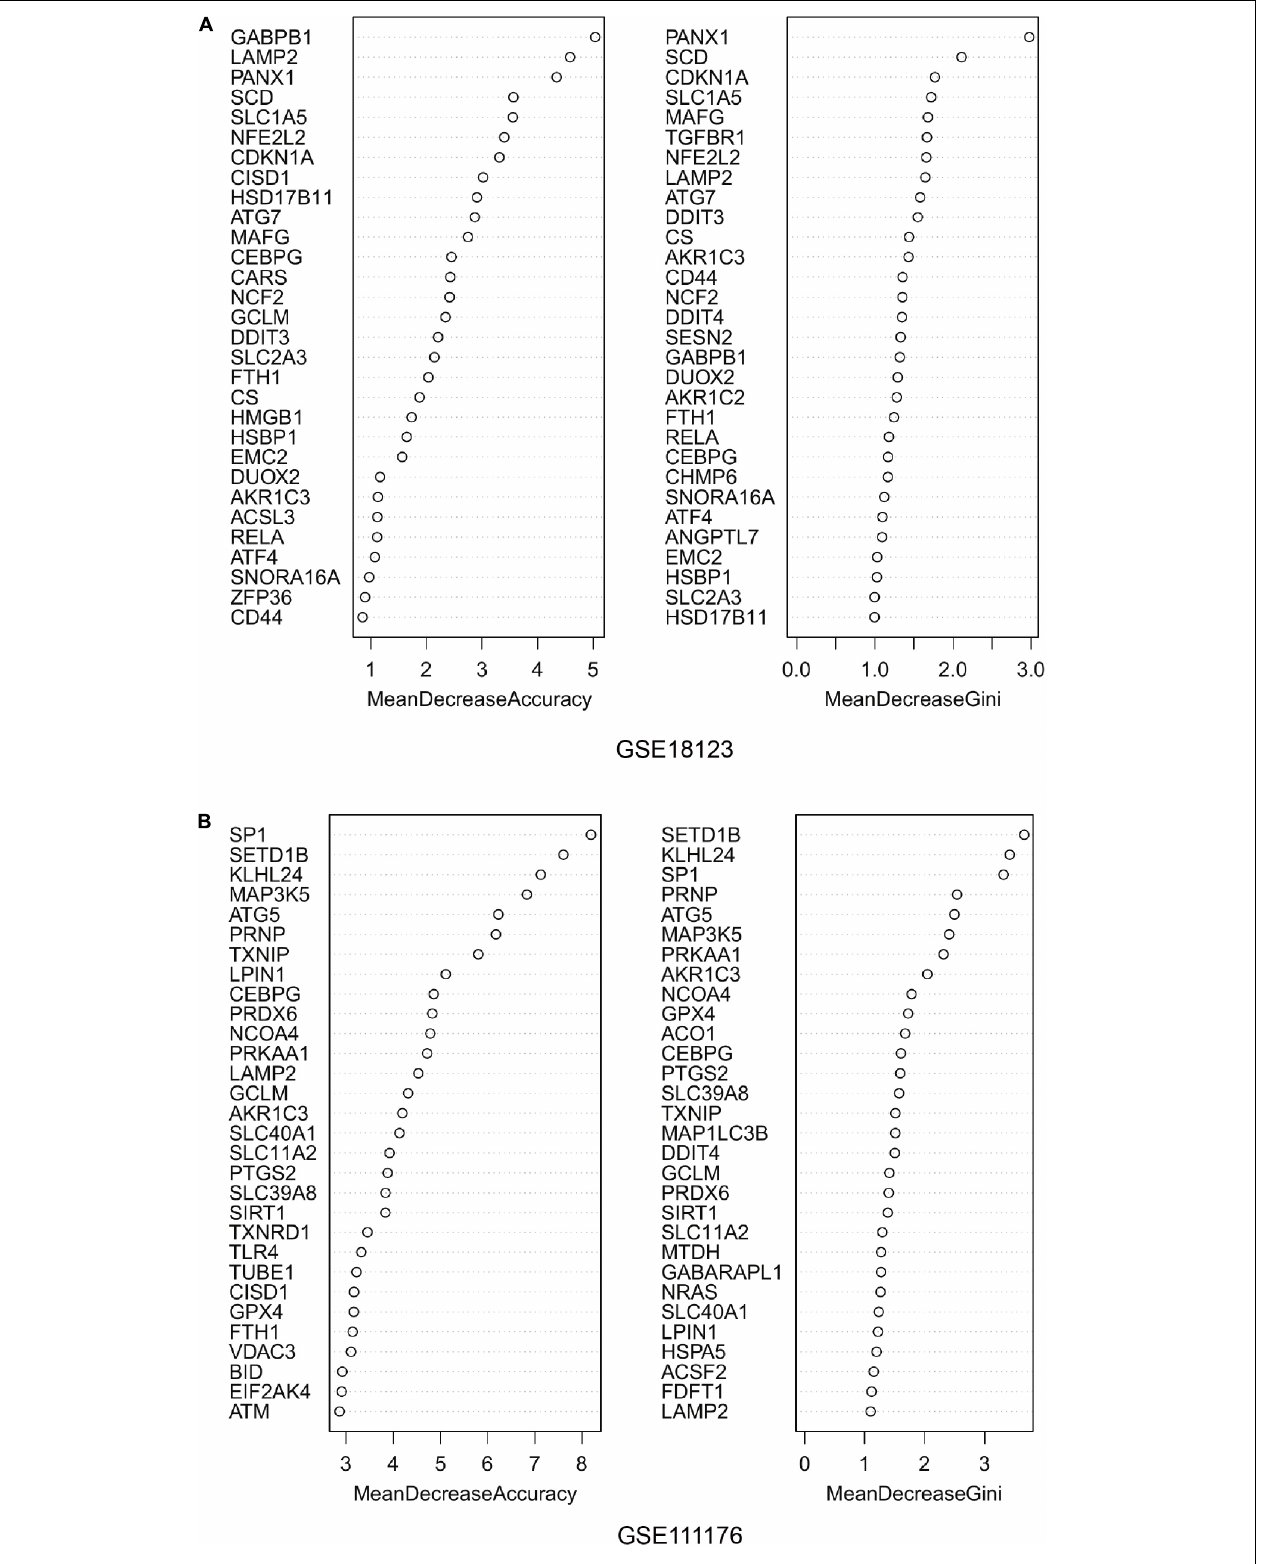
FIGURE 3 | Random forest analysis. (A) Accuracy value and Gini value of candidate ferroptosis-related genes in GSE18123. (B) Accuracy and Gini values of candidate ferroptosis-related genes in GSE111176.